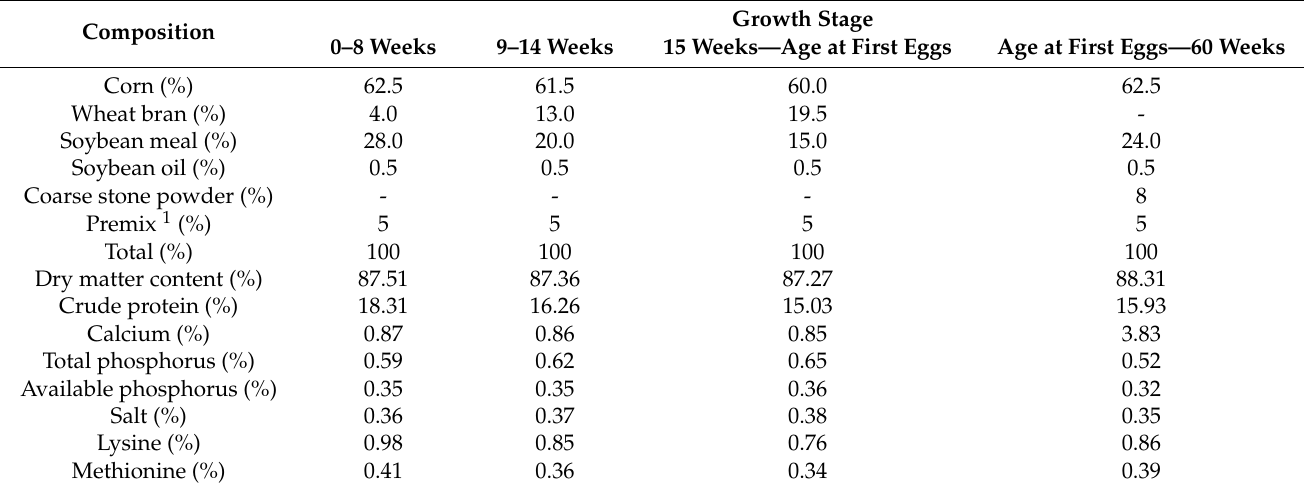
Table 2. The composition of the basal diet (as-fed